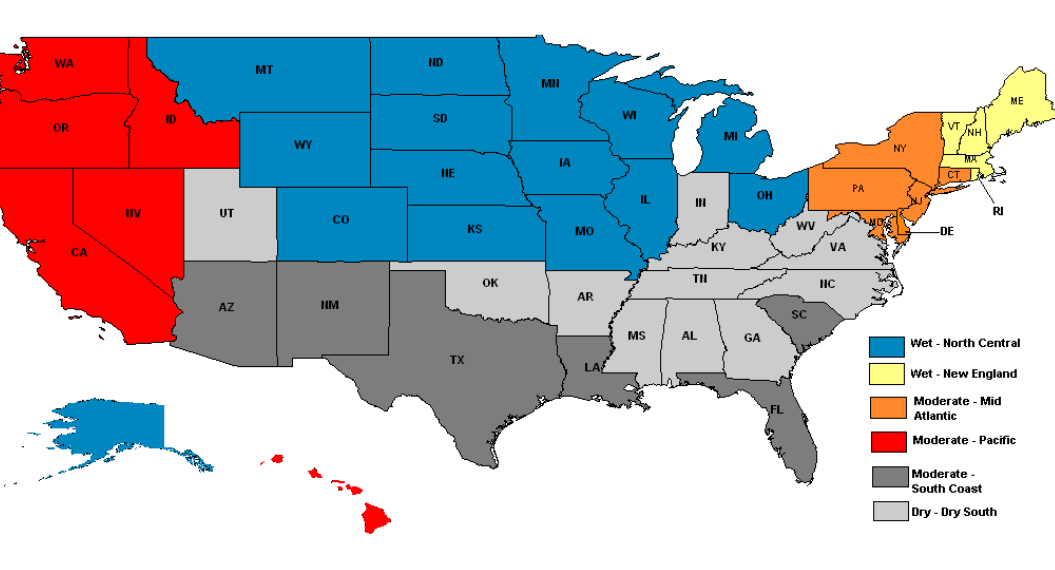
Figure 1. Map of US Regional Drinking Groups. North Central, blue; New England, yellow; Middle Atlantic, orange; Pacific, red; South Coast, dark grey; Dry South, light gray. Groups are also identified as Wet, Moderate or Dry based on the % reporting 5+ drinking day in the past month and per capita apparent consumption of alcohol.